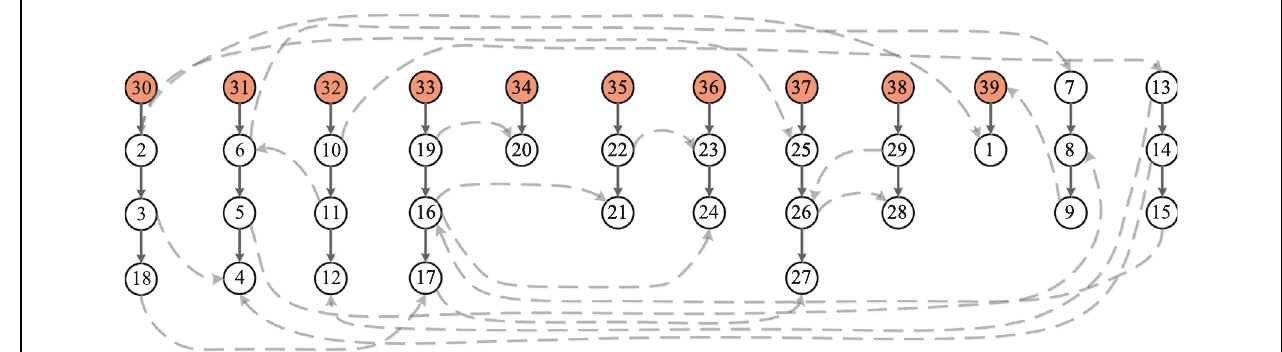
FIGURE 6 | The forcing paths in the IEEE 39 bus system. Solid lines are edges in paths and dotted lines are other edges in the system.